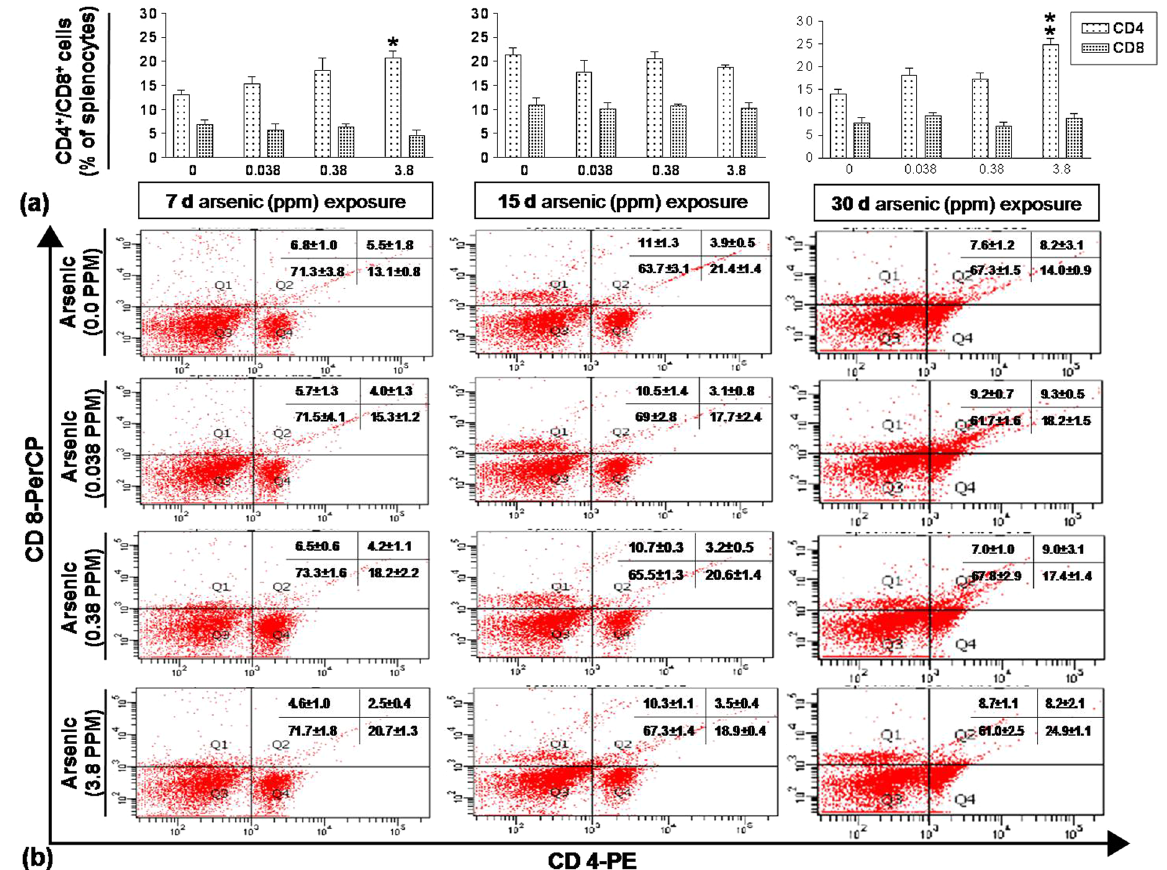
Figure 3. Effect of arsenic exposure on splenic CD4 + T cells. Splenocytes (0.2 × 10 6 ) isolated from mice treated with arsenic (0.00, 0.038, 0.38 and 3.8 ppm) orally for 7, 15 and 30 days were stained with PE conjugated anti-CD4 monoclonal antibody and PerCP conjugated anti-CD8 monoclonal antibody. The PE and PerCP fluorescence were measured using flow cytometer. (a) Percentage of CD4 + and CD8 + T cells in splenocytes at 7, 15 and 30 days. (b) Each representative dot plot reflects splenocytes stained CD4 and CD8 antibodies. Arsenic promoted percent distribution of CD4 + T cells in spleen. Values are mean ± S.E. (n = 9 per group). * p < 0.05, ** p < 0.01 and *** p < 0.001 compared to